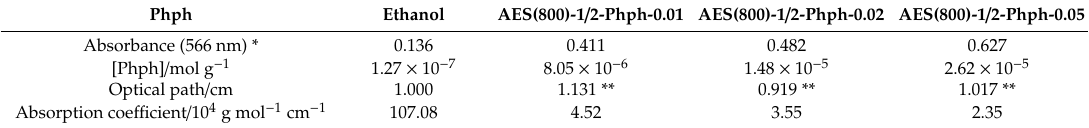
Table 2. UV–Vis data values obtained from the doped OIH materials spectra (Figure 4).